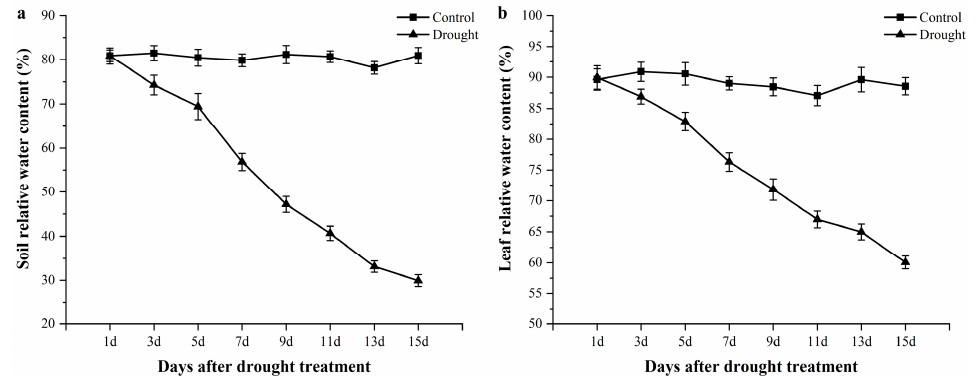
Figure 1. The relative water content changes of soil ( a ) and leaf tissues ( b ) during the drought period. Value is the mean of three replicates ± standard error.